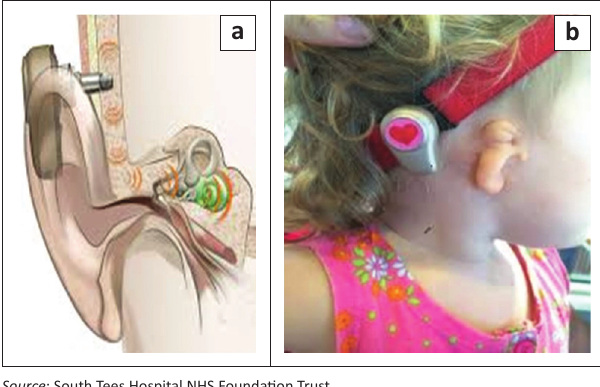
FIGURE 1: Percutaneous bone conduction device (a) and transcutaneous bone conduction device on a softband